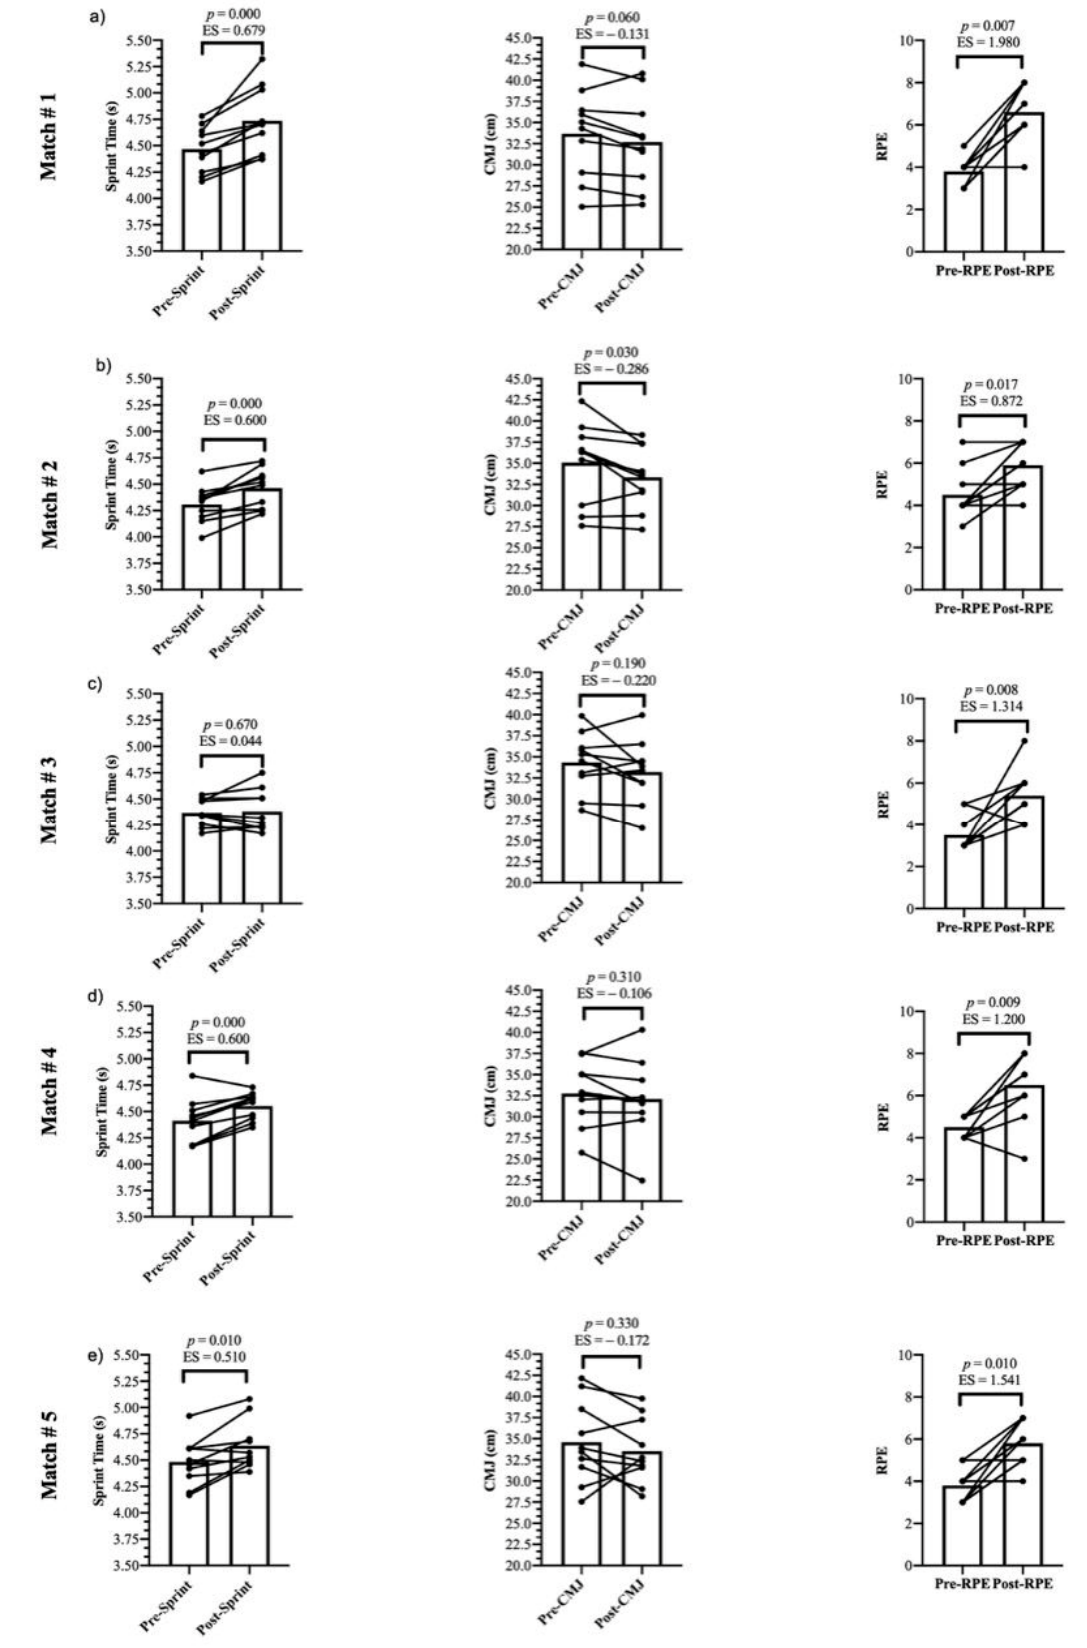
Figure 2. Match 1 to 5 (Figure a – e ) physical and subjective responses from Pre 1stH to Post